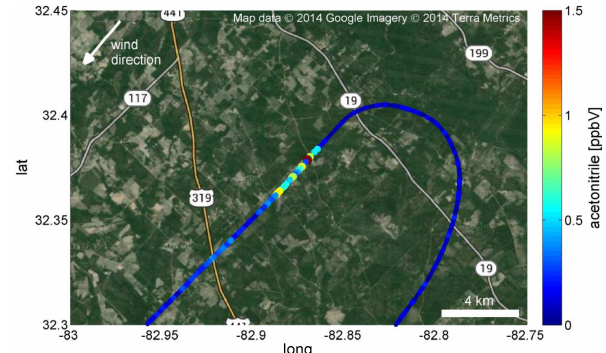
Figure 6. High-spatial-resolution data of acetonitrile during tran- sect of an agricultural crop-burning plume on 23 September 2013 near Dublin, GA, USA.